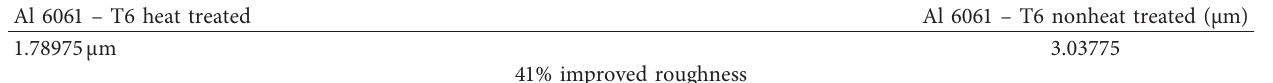
Table 5: Percentage of improvement in surface roughness Ra by DHT method.